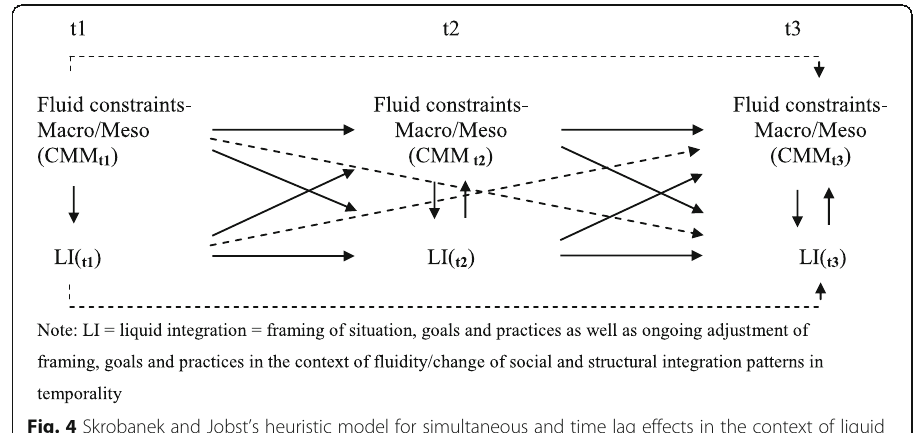
Fig. 4 Skrobanek and Jobst ’ s heuristic model for simultaneous and time lag effects in the context of liquid integration. Source: Skrobanek and Jobst (2019, p.